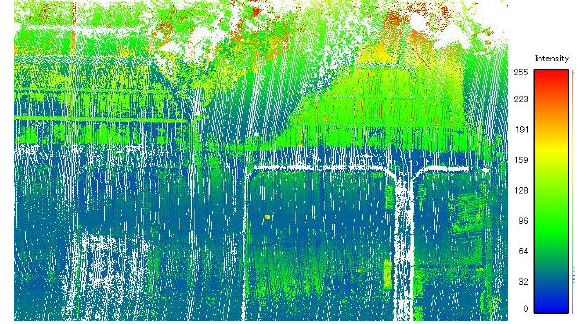
Figure 13. Reflection intensity image of channel 11